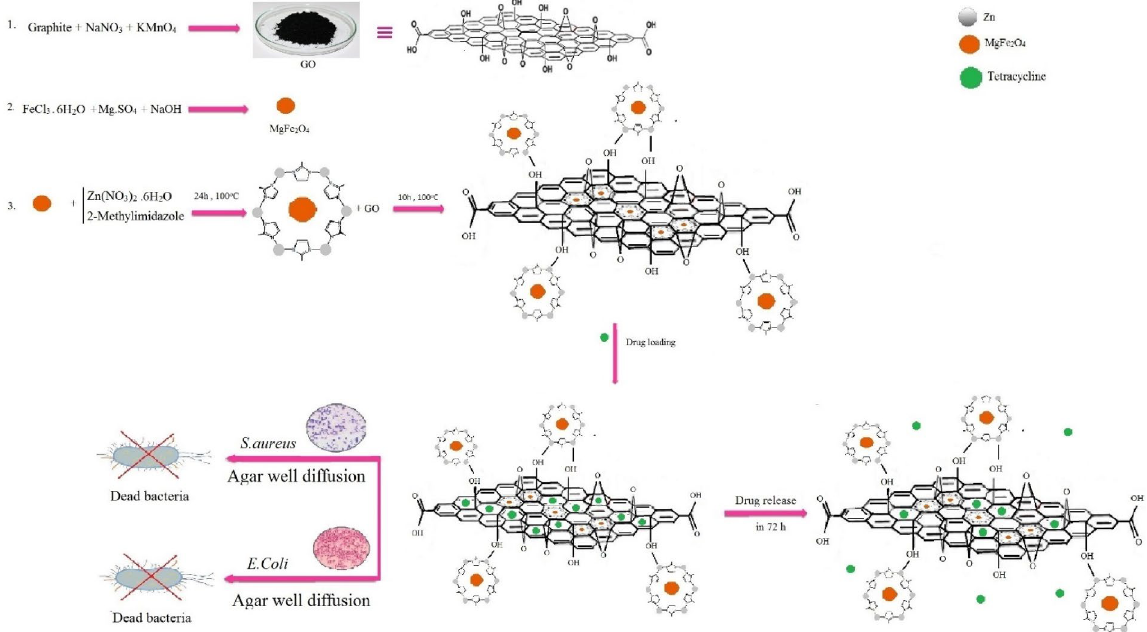
Figure 2. Simulation of the preparation of the ZIF-8/GO/MgFe 2 O 4 framework, drug loading, release and antibacterial